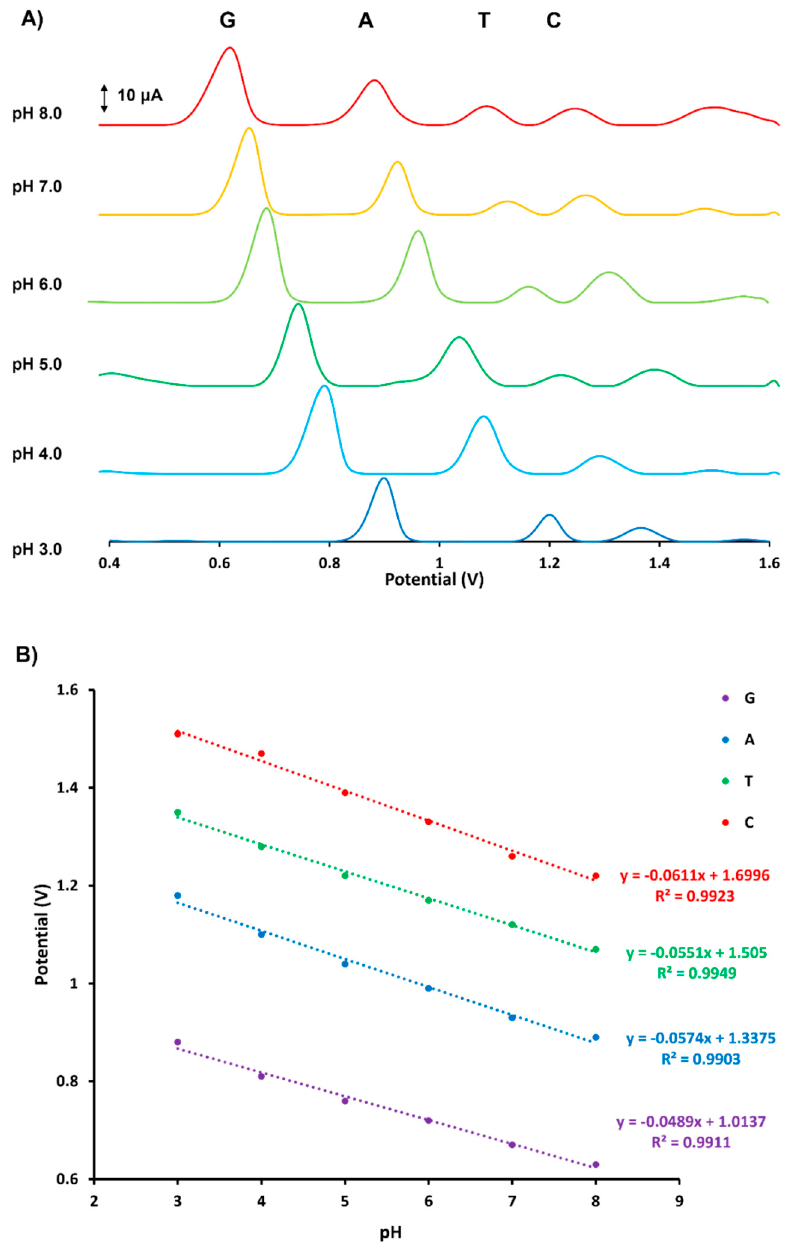
Figure 4. ( A ) Voltammograms obtained from the simultaneous electrochemical detection of the four DNA bases using DPV at varying pH conditions (pH 3.0, 4.0, 5.0, 6.0, 7.0 and 8.0). The concentrations of DNA bases were 33.3 µM for G and A, and 333.3 µM for T and C, and ( B ) plot showing the linear relationship between anodic peak potential and pH.